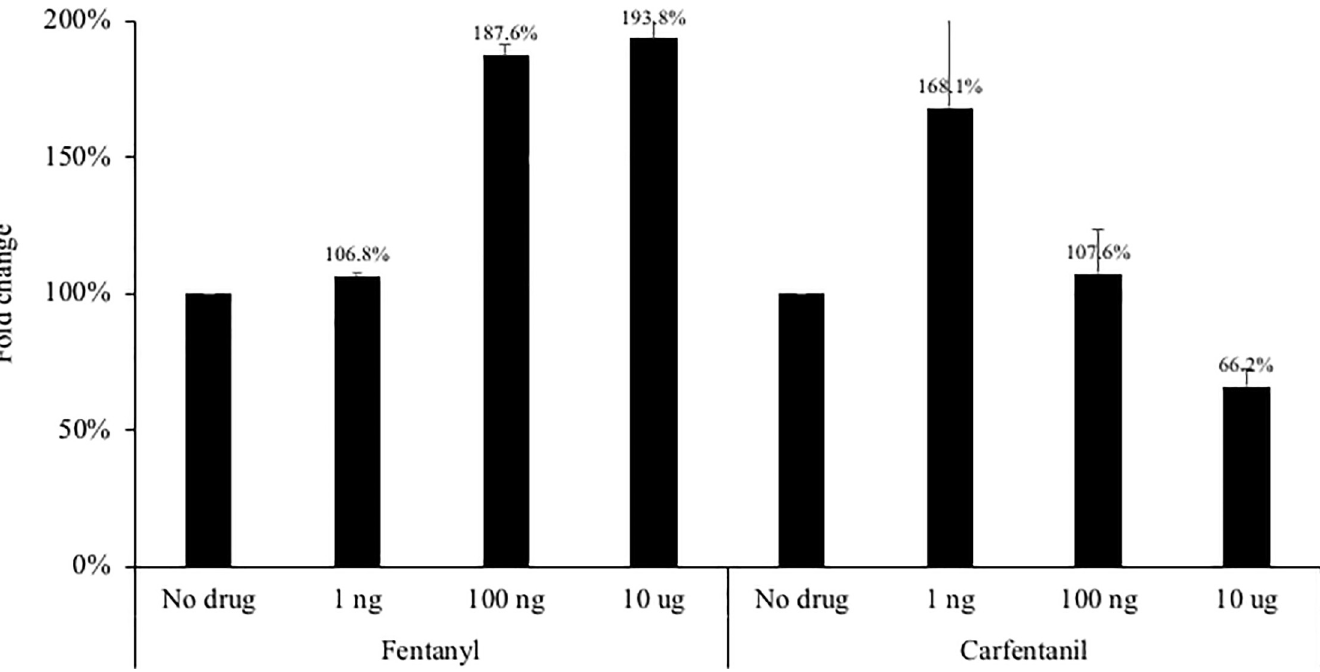
Fig 2. The Huh7.5JFH1 hepatocyte cell line–which constitutively expresses infectious HCV–was seeded at 500,000 cells per well. Fentanyl or carfentanil was added to culture medium after 24 hours. After 24 hours of incubation with drug, HCV core protein (ng/mL) was quantified in culture supernatants. ANOVA for dose effect: p = 0.0007 for fentanyl and p = 0.041 for carfentanil.